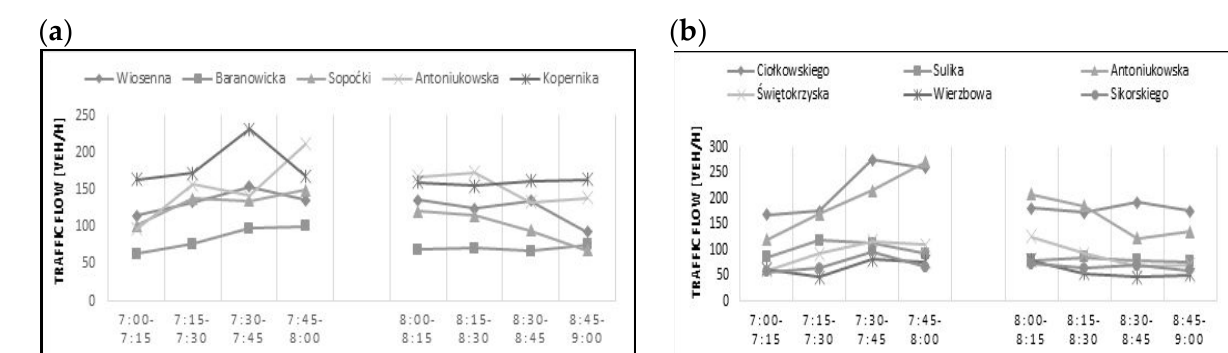
Figure 5. 15-minute traffic intensity variations ( a ) main routes ( b ) alternative routes.